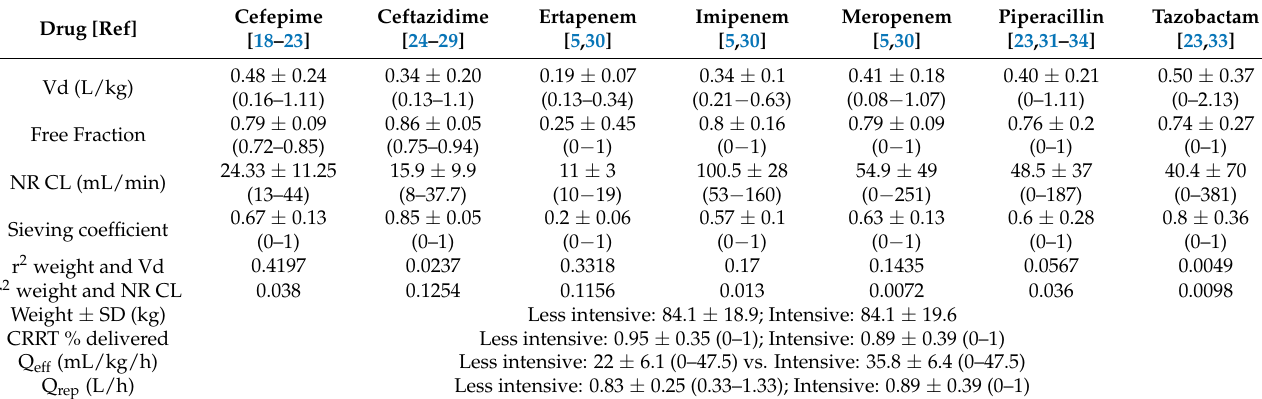
Table 3. Adapted pharmacokinetic parameters used in Monte Carlo simulations